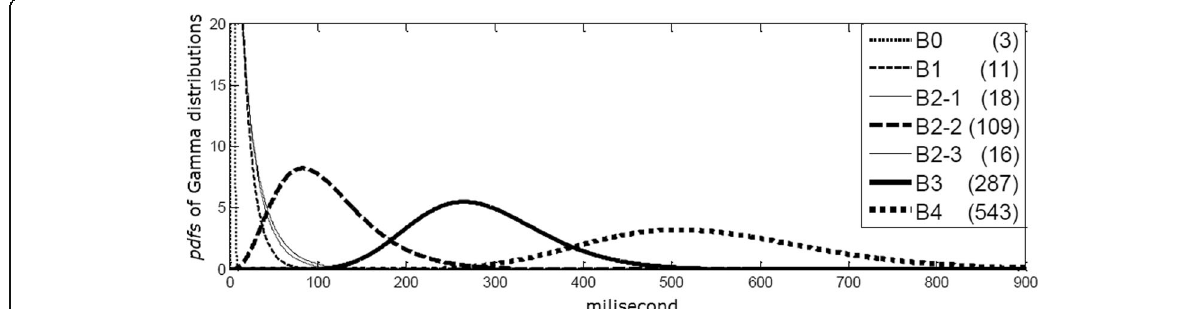
Fig. 2 Distribution ( pdf ) of pause durations (ms) for the seven break types. The average pause duration (ms) for each of the prosodic break types is displayed in parentheses